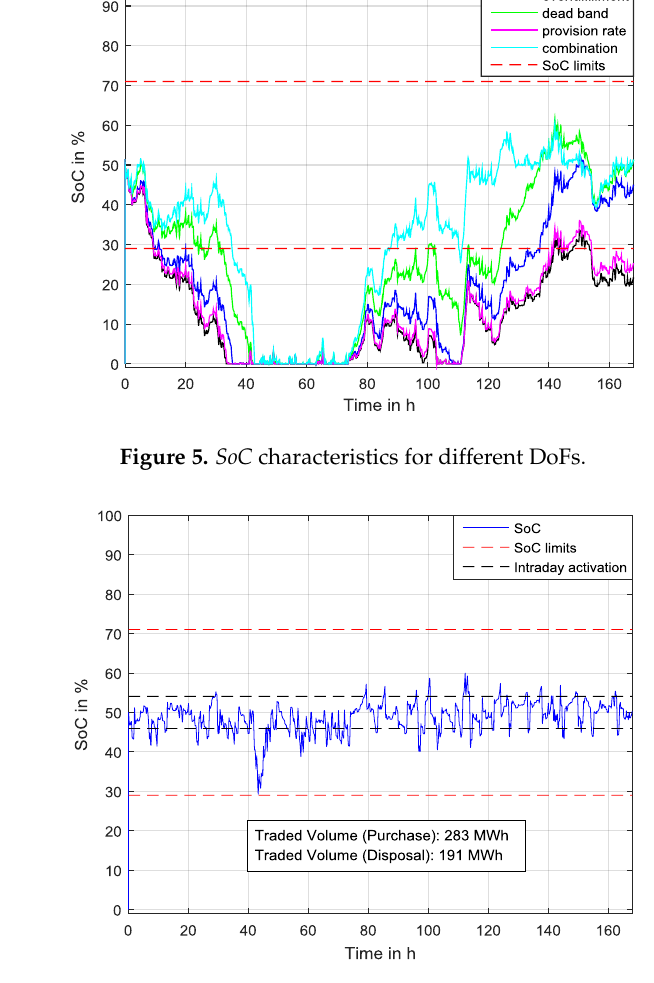
Figure 6. SoC characteristics when using only scheduled transactions.